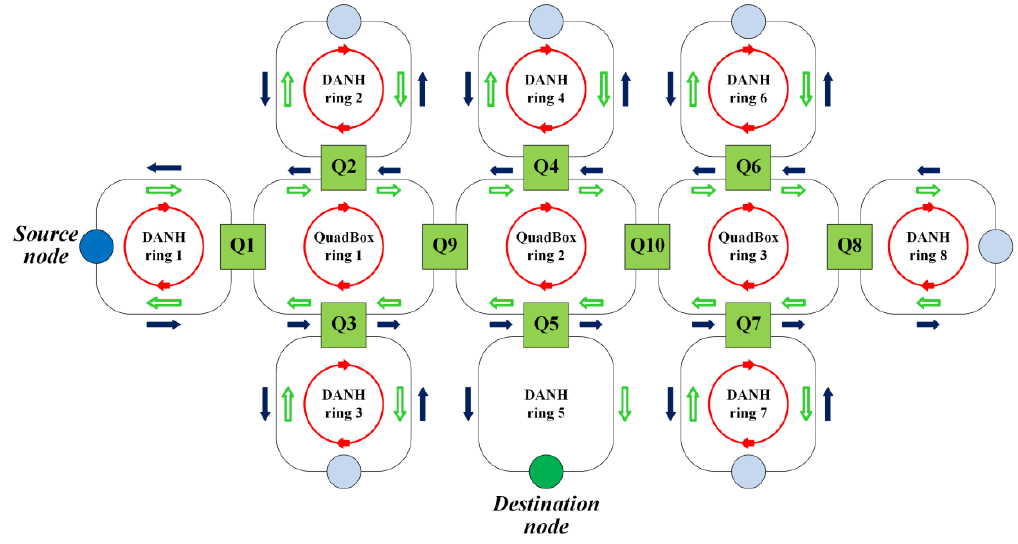
Figure 11. Network traffic under standard HSR protocol in a failure-free